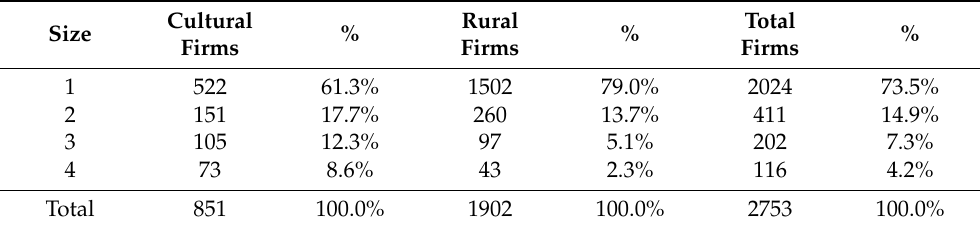
Table 4. Firm size